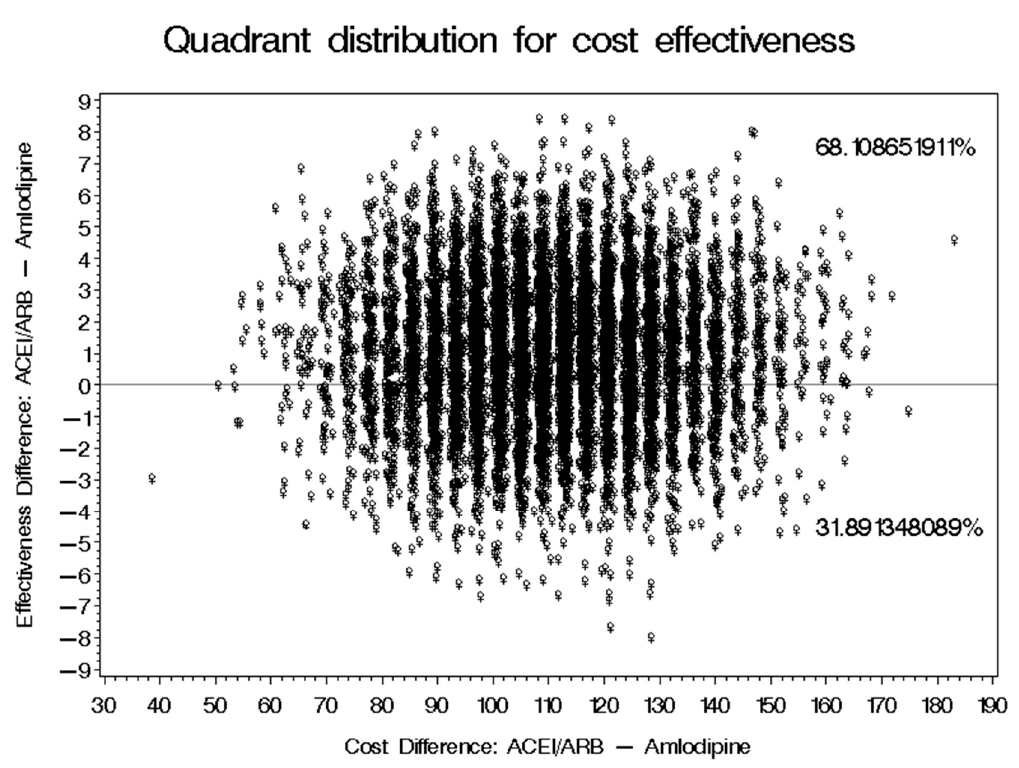
Figure 4. The probabilistic sensitivity analysis of the cost effectiveness of ACEIs/ARBs versus amoldipine in the management of high DBP.